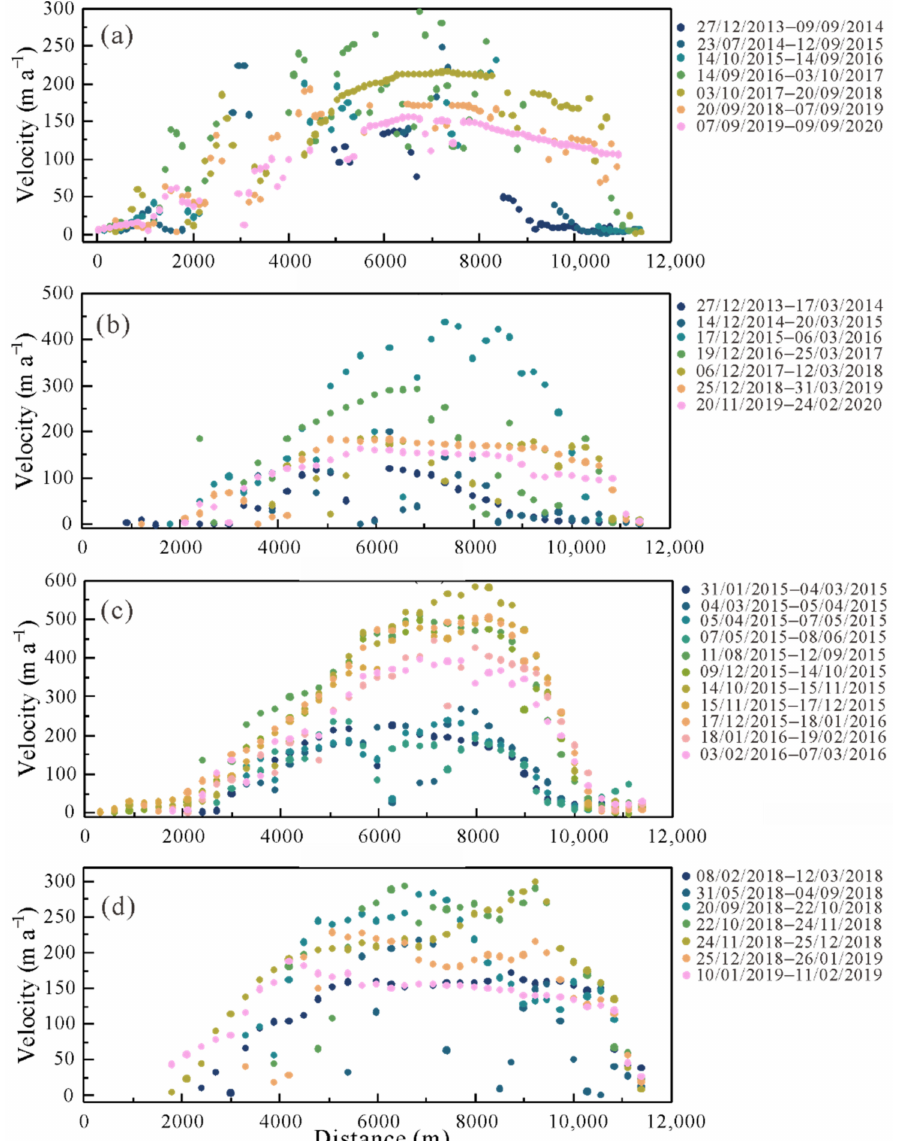
Figure 5. Velocity changes of glacier G085885E34389N: ( a ) derived from Landsat pairs with a ~1-year interval by the Co-registration of Optically Sensed Images and Correlation (COSI-Corr) package and ( b – d ) extracted from the Global Land Ice Velocity Extraction from Landsat 8 (GoLIVE)